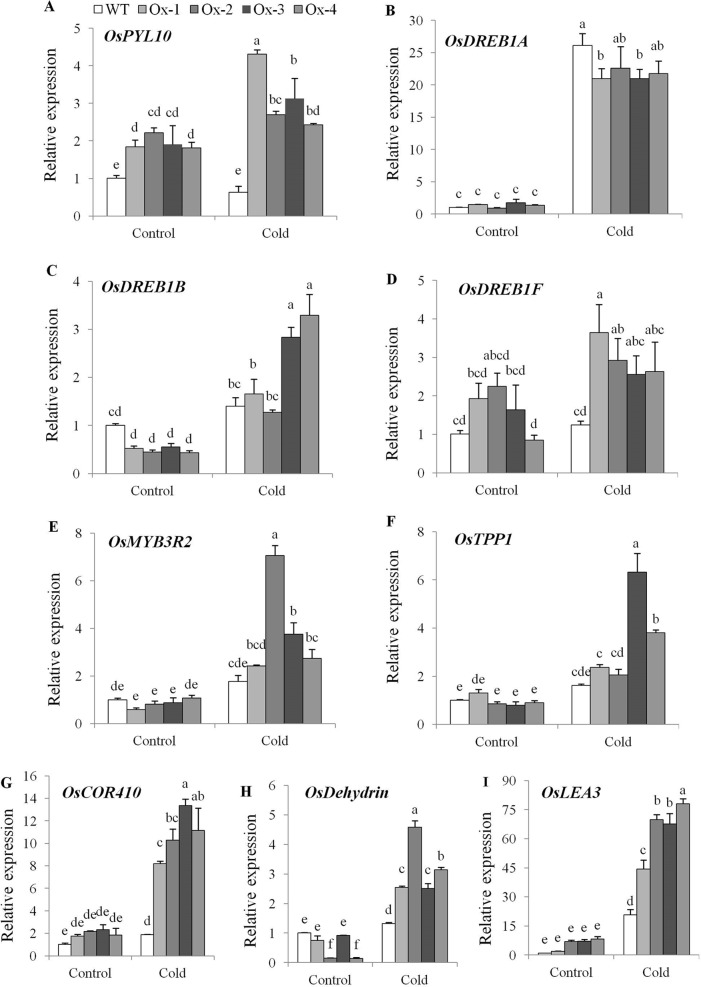
Expression analysis of cold stress responsive genes. (A) Expression of PYL10 under cold stress. (B–I) qRT-PCR expression analysis of cold stress responsive genes viz., OsDREB1A, OsDREB1B, OsDREB1F, OsMYB3R2, OsTPP1, OsCOR410, OsDEHYDRIN and OsLEA3 under cold stress. Total RNA isolated from leaf tissues of 60 days old plants treated with cold (15°C for 48 h followed by 6°C for 48 h). The experiments were performed with three biological replicates (n = 3). Error bar indicates ± SE. Statistical differences are shown on the bars by labelling significantly different groups with different letters.